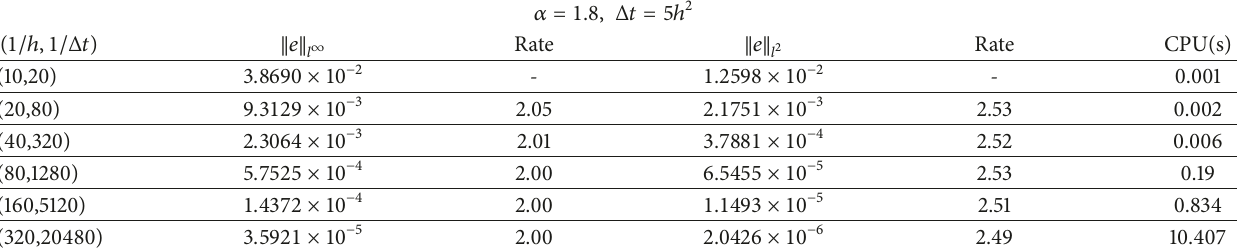
Table 8: Error and convergence rates for Example